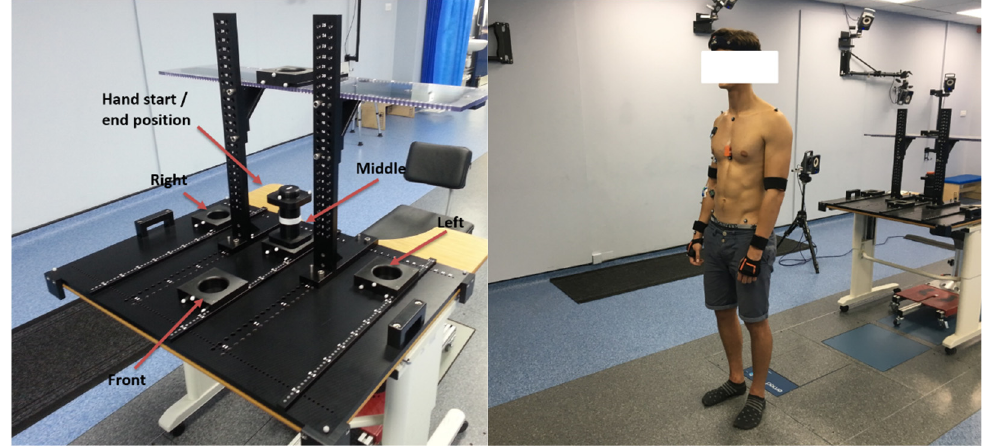
Figure 3. Photographs of the experimental setup used for the acquisition of data used in this study. The configuration pictured is for the reach-grasp activity.